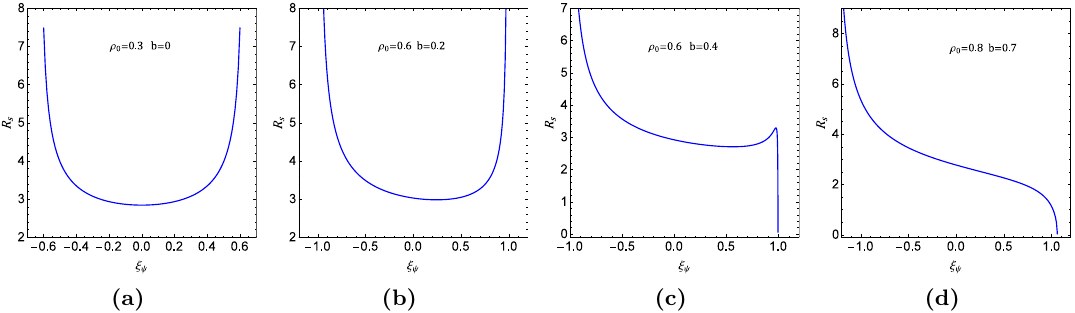
Figure 1 . Changes of R s with (cid:24) for the rotating squashed KK black hole with di(cid:11)erent (cid:26) 0 and b . Here we set (cid:26) M =